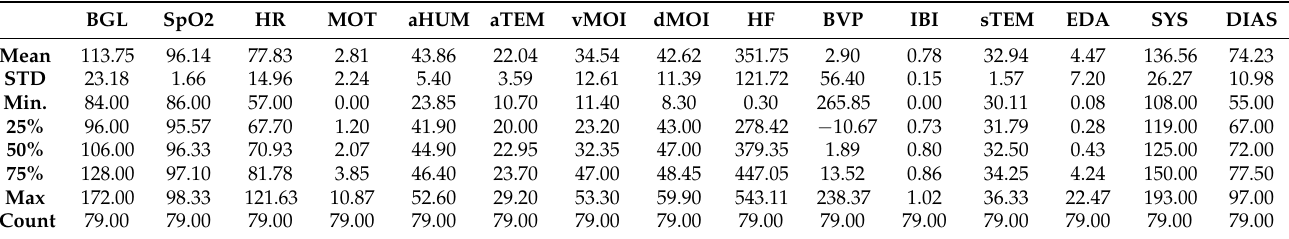
Table 5. Statistical analysis of Subject 2 from the UofM